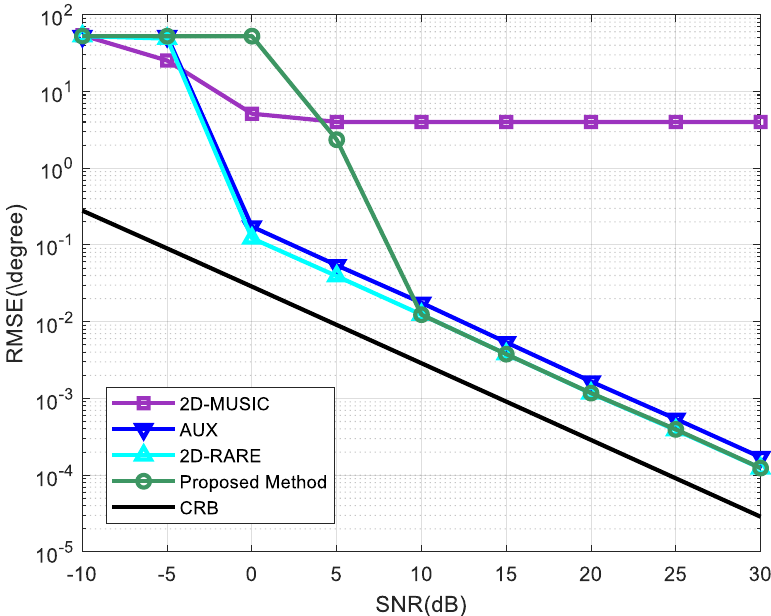
Figure 3. RMSEs of Root mean square errors (RMSEs) of direction-of-arrival (DOA) estimates versus Figure 3. RMSEs of DOA estimates versus SNR. The number of snapshots is 1000. signal-to-noise ratio (SNR). The number of snapshots is 1000.